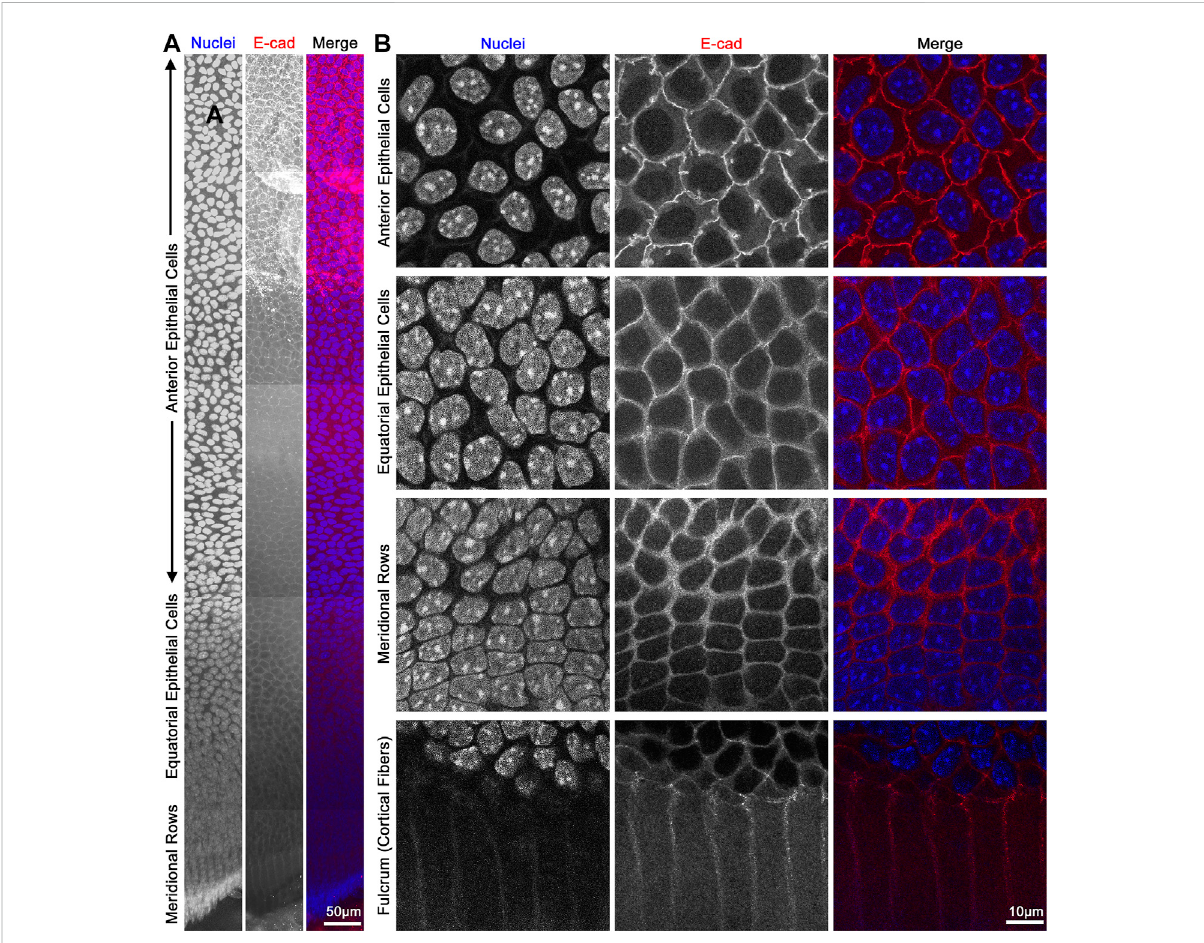
FIGURE 8 Flat mount of lens epithelial cell monolayer. (A) Lens capsule fl at mount was stained for E-cadherin (red) and nuclei (blue). Tiled Z-stack scans fromtheanterior(top)tothemeridionalrowsattheequator(bottom)werestitched,andthisimageisamaximumintensityprojectionofthestitched Z-stacks compressed into a 2D image. Scale bar, 50 μ m. (B) Magni fi ed images of epithelial cells from different regions of the lens. As expected, E-cadherin outlines the membrane of the epithelial cells and has reduced signals after epithelial cells differentiate into fi ber cells at the lens fulcrum. It should be noted that the spacing of the nuclei changes slightly between anterior vs. equatorial epithelial cells. Scale bar, 10 μ